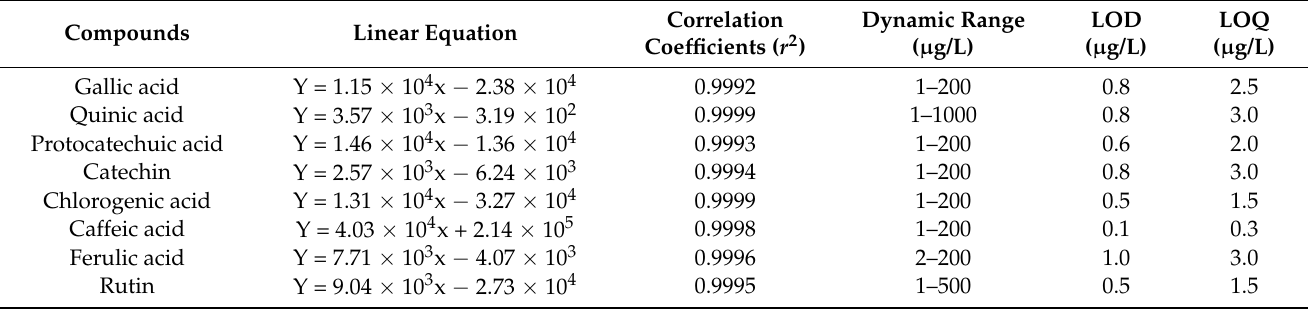
Table 3. Regression equation, correlation coefficient, linear range, limit of detection (LOD), and limit of quantitation (LOQ) of banana phenolic